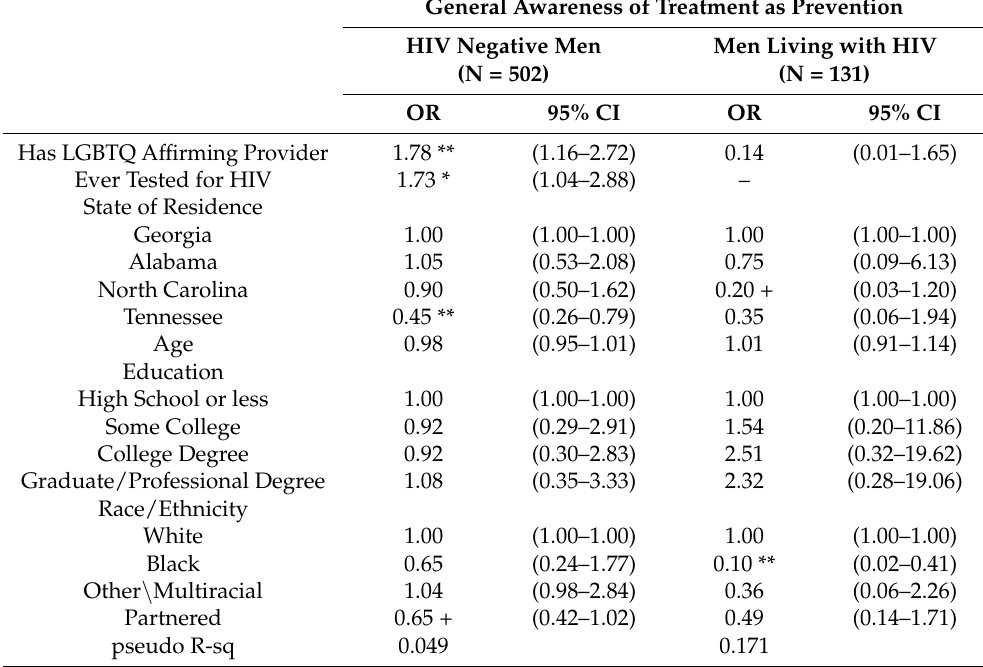
Table 5. Estimates of general awareness of treatment as prevention among a sample of midlife and older gay and bisexual men in the US south by HIV status, VUSNAPS. General Awareness of Treatment as Prevention HIV Negative